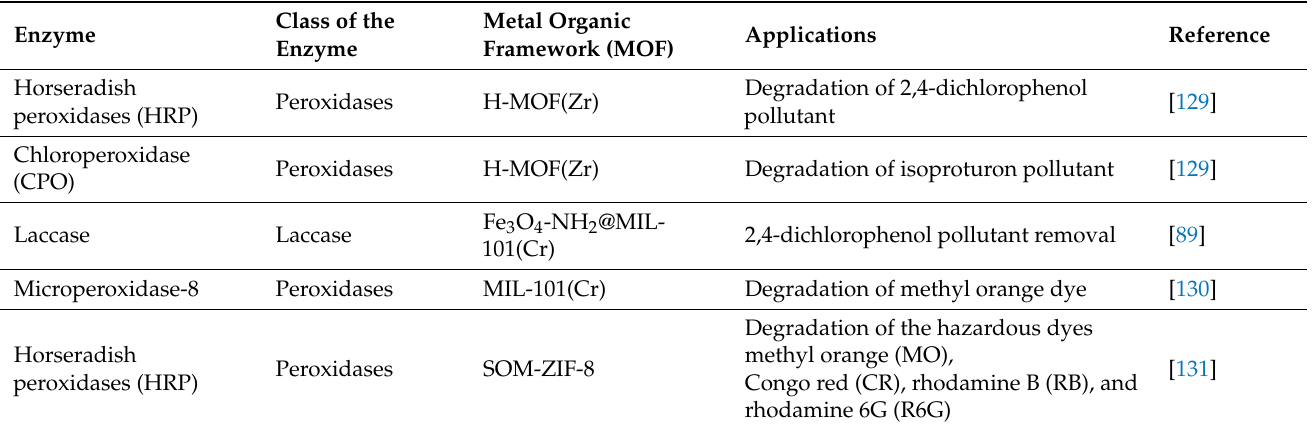
Table 3. Examples of different enzymes immobilized on MOF for water remediation